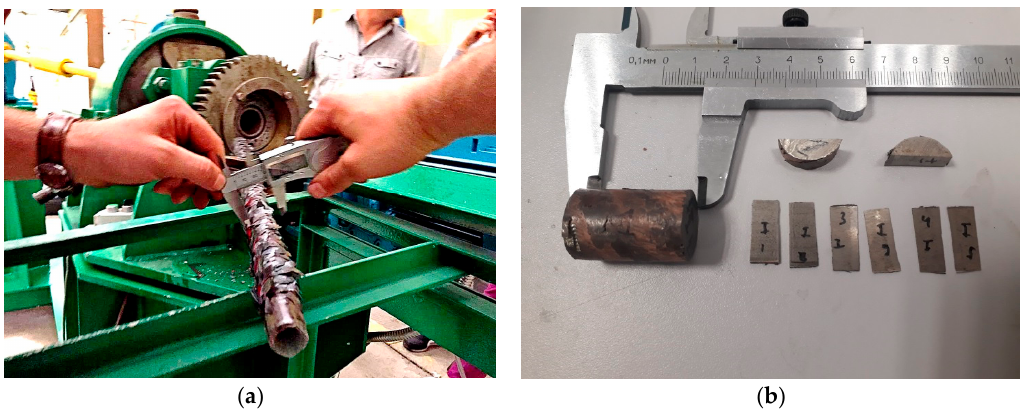
Figure 10. Workpiece after radial-shear rolling ( a ) and samples from the final bar ( b ) to study the microstructure.